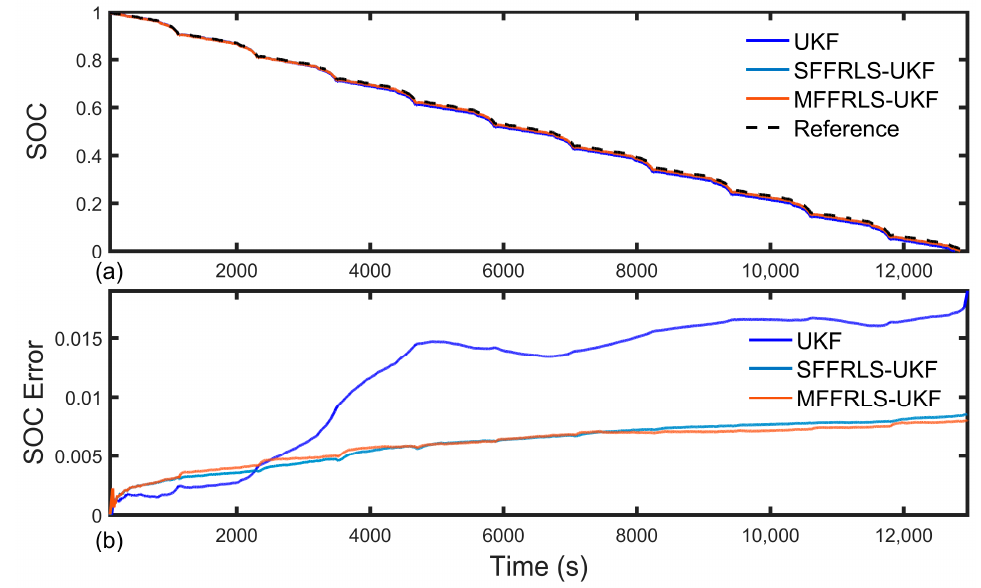
R by SFFRLS-UKF and MFFRLS-UKF. 0